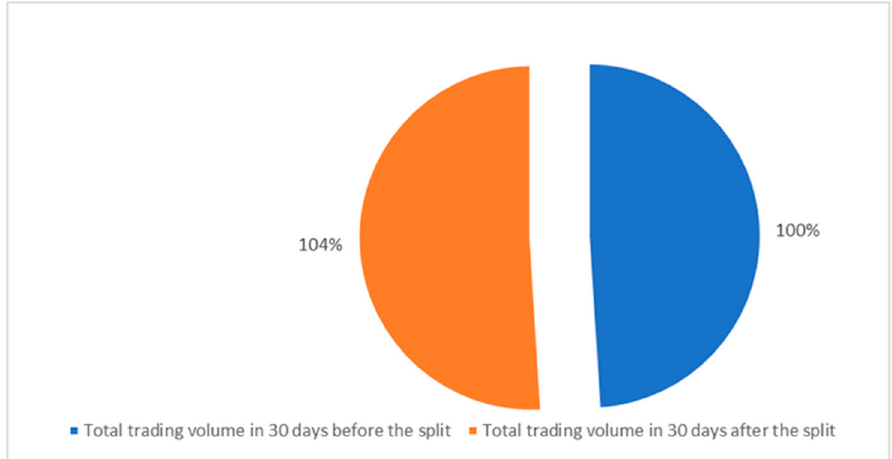
Figure 2. Total trading volume over 30 days after (orange area online; left side of the cake) and before (blue area online; right side of the cake) the